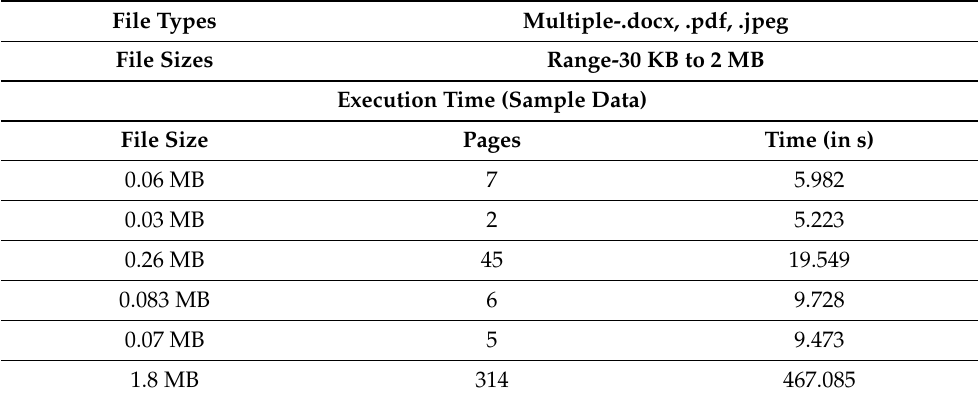
Table 3. File types used, sizes and execution times of the proposed